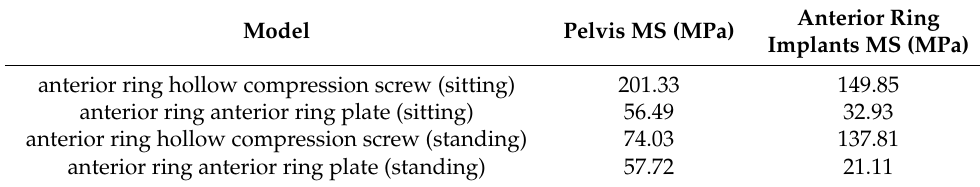
Table 4. The maximum stresses (MS) of different finite element model after loading the